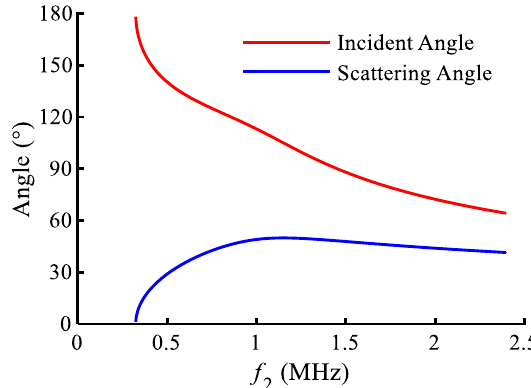
Figure 1 Geometric representation of two incident waves and generated mixing frequency wave